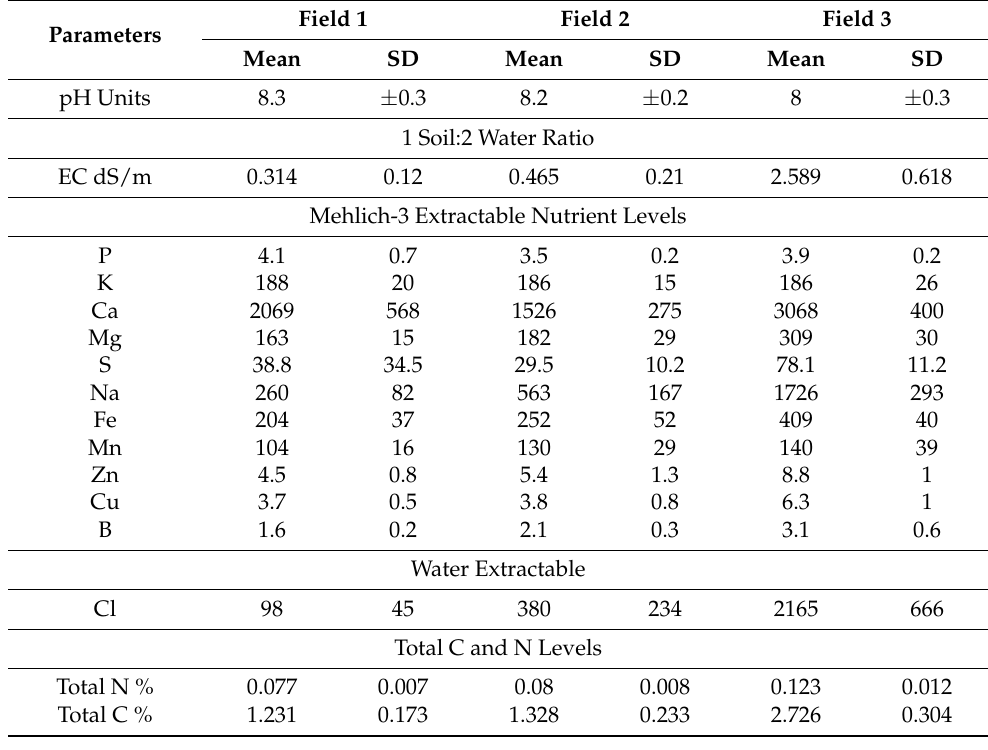
Table 4. The pH, electrical conductivity (EC), Mehlich-3 extractable nutrient levels (mg/kg), % total N and C, and chloride levels (mg/kg) of three fields at the study site. Mean of six composite soil samples collected in each field (SD: Standard deviation).